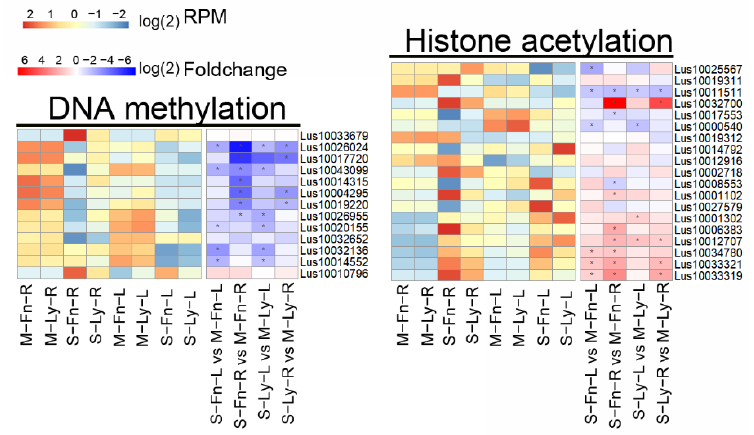
Figure 9. Expression of genes related to epigenetic modification between root and leaf in Fanni and Longya10 under saline stress. M −Fn−R and M −Ly−R represent the root samples derived from Fanni and Longya10 plants, respectively. S −Fn−R and S −Ly−R represent the saline-stress-treated root samples derived from Fanni and Longya10 plants, respectively. M−Fn−L and M−Ly−L represent the leaf samples derived from Fanni and Longya10 plants, respectively. S−Fn−L and S−Ly−L represent the saline-stress-treated leaf samples derived from Fanni and Longya10 plants, respectively.